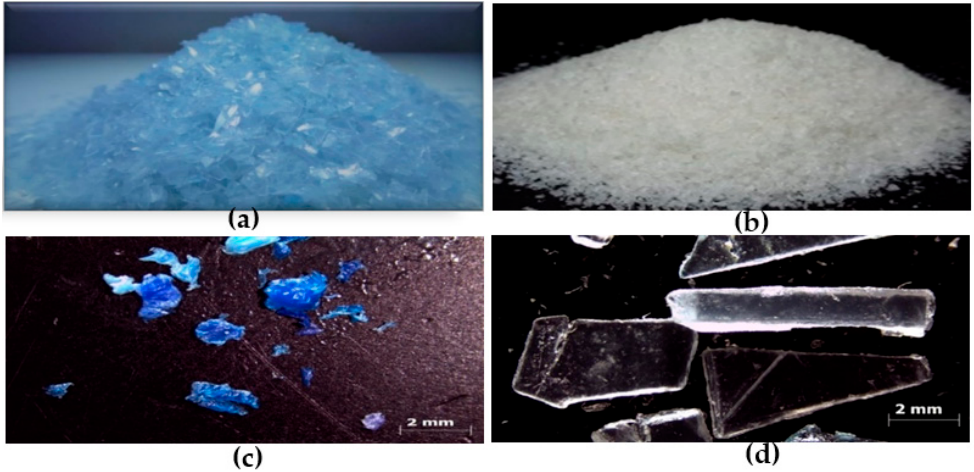
Figure 1. Polymers used: ( a , c ) polypropylene (PP) and ( b , d ) high-density polyethylene (HDPE) after cut by knife.